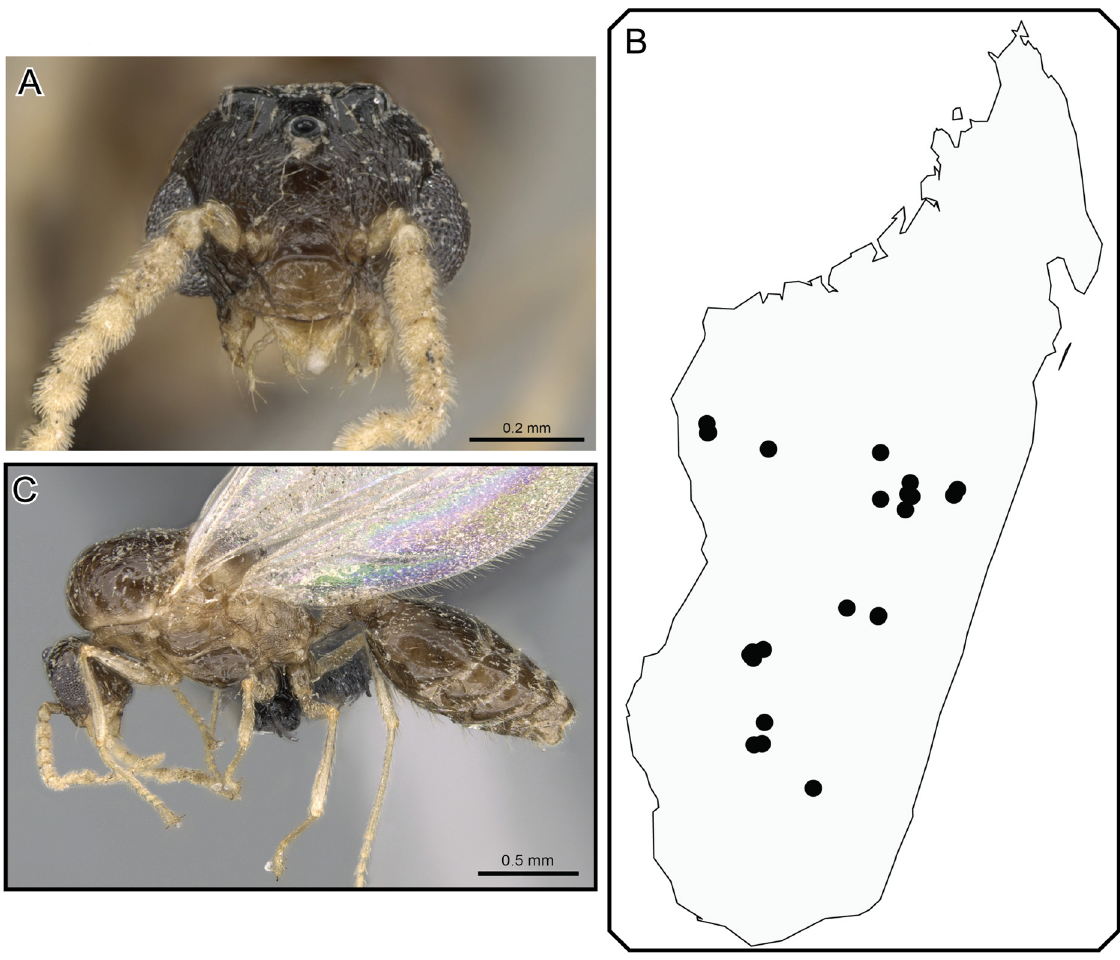
Fig. 21. Crematogaster sewellii Forel, 1891, male and distribution. A, C. Male (CASENT0317761). A. Full-face. C. Profile. B. Species